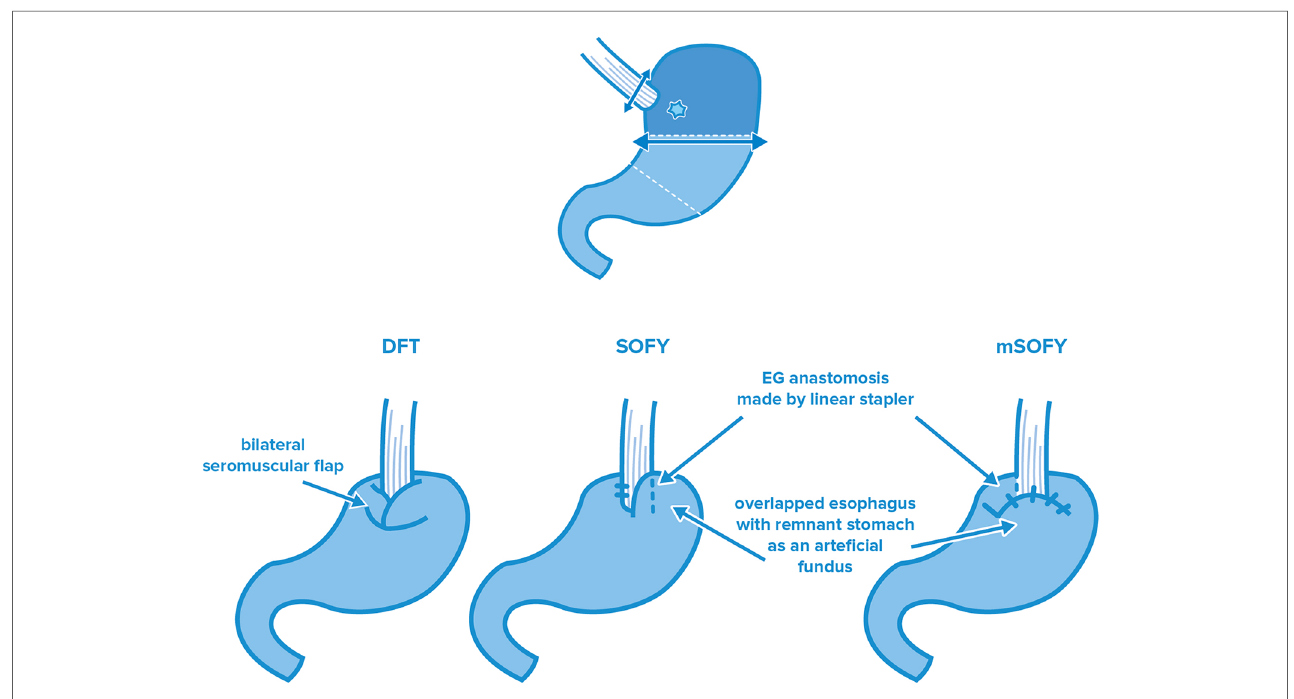
FIGURE 2 Esophagogastrostomy fl ap techniques after PG: double — fl ap technique (DFT), side overlap funduplication (SOFY), and modi fi ed side overlap funduplication (mSOFY).